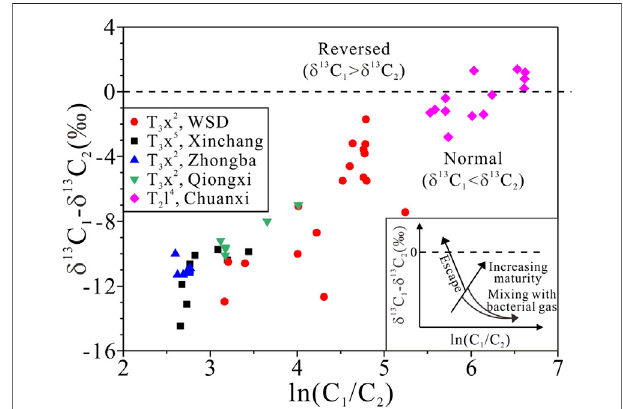
FIGURE 8 | The diagrams of δ 13 C 1 - δ 13 C 2 versus ln (C 1 /C 2 ) of the T 3 x 2 gasfrom the Western Sichuan Depression (modi fi edafter Prinzhoferand Huc,